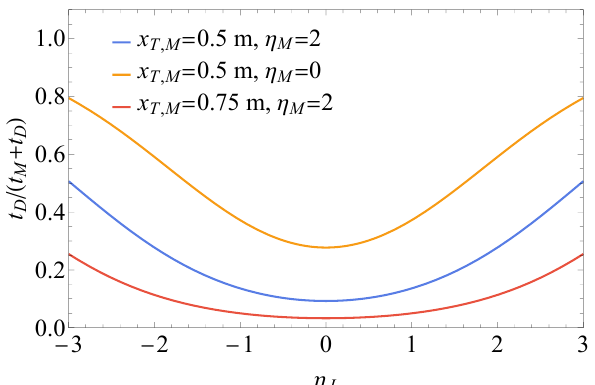
Figure 7 . The overall suppression in the width due to the daughter time fraction as a function of η J using β M = 0 . 4 with x T,M = 0 . 5 m and η M = 2 (blue), x T,M = 0 . 5 m and η M = 0 (yellow), and x T,M = 0 . 75 m and η M = 2